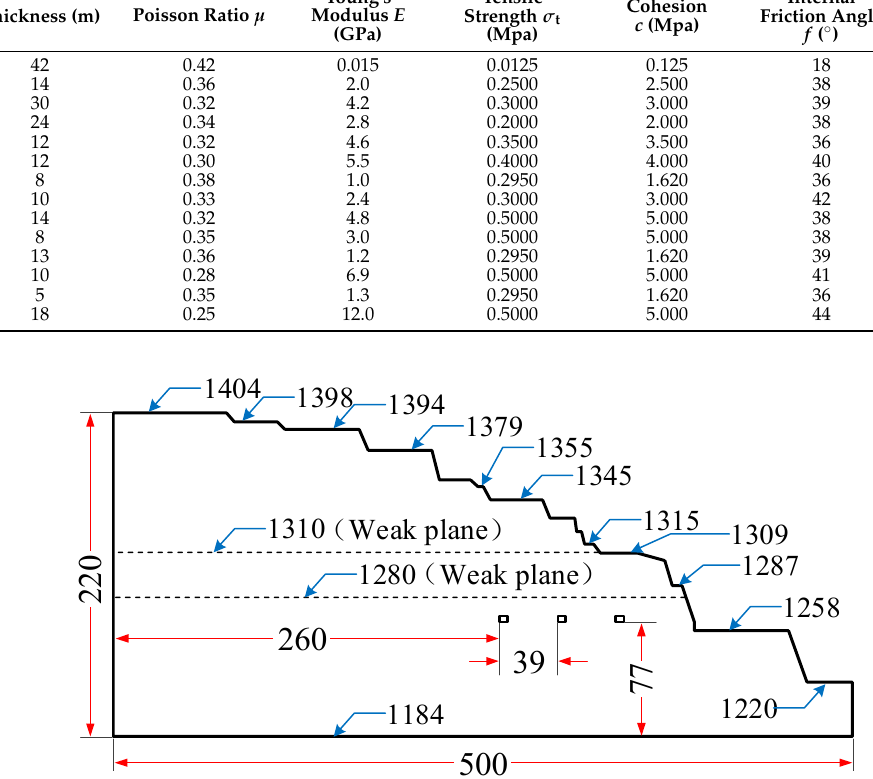
Figure 3. Model size and elevation (m).